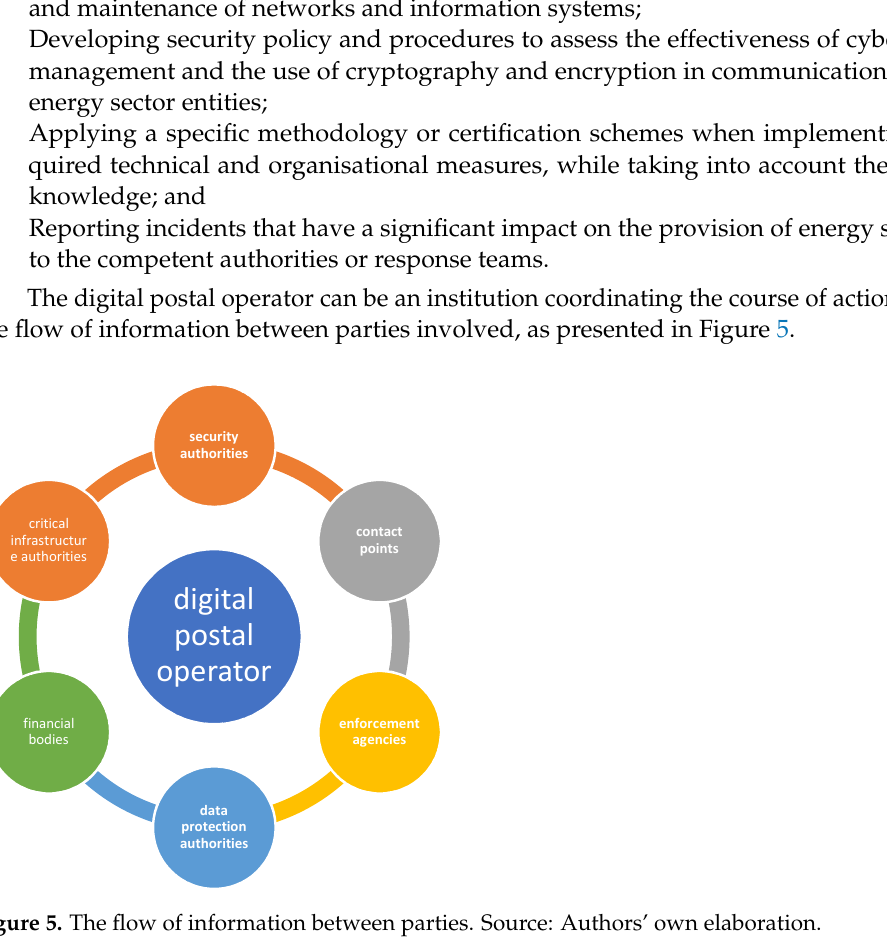
Figure 5. The flow of information between parties. Source: Authors’ own elaboration.